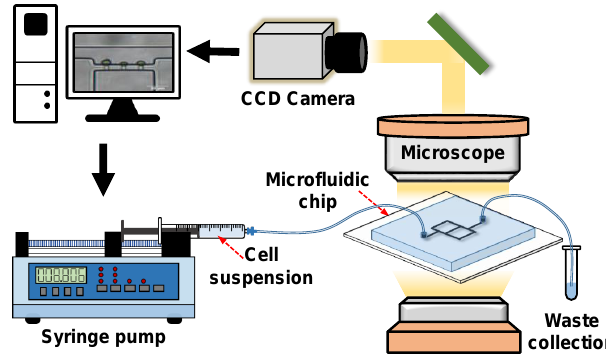
Figure 2. Schematic of the microfluidic micropipette aspiration